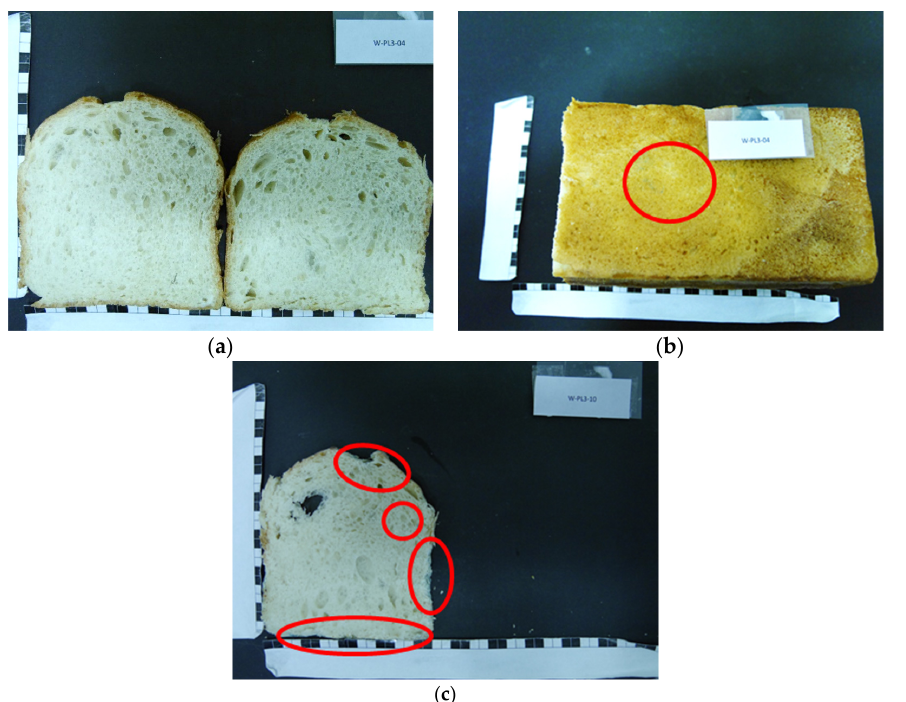
Figure 3. Growth of molds on pan wheat bread stored in a plastic bag at room temperature. ( a ) Crumb after four days of storage without visually detectable growth of molds. ( b ) Bottom view of the bread loaf showing the first molds after four days of storage. ( c ) Crumb with excessive growth of molds at the side, top and bottom after ten days of storage.